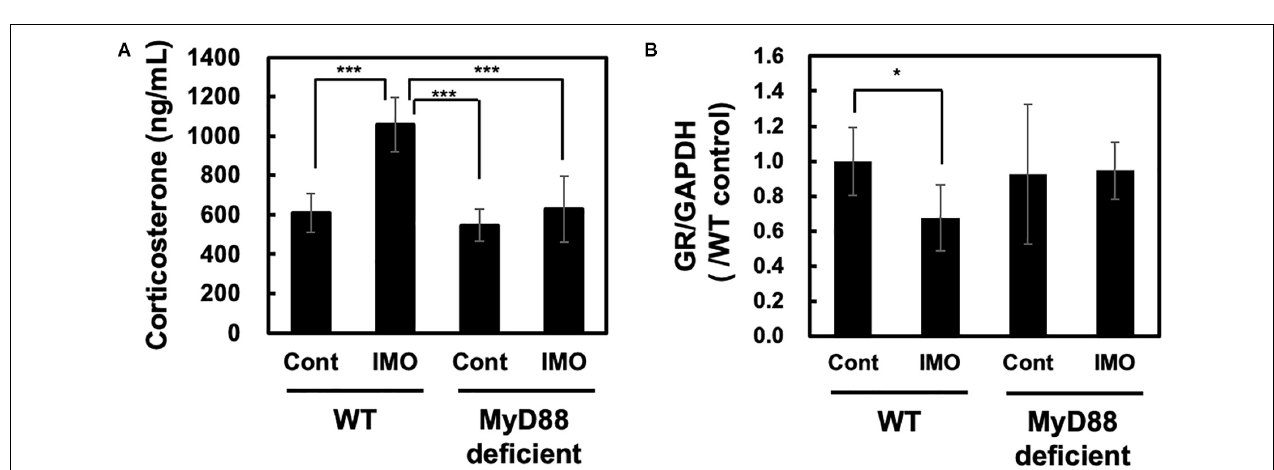
FIGURE 2 | Corticosterone and glucocorticoid receptor levels in MyD88-deficient mice exposed to immobilization stress. (A) Immobilization stress-induced production of corticosterone was impaired in MyD88-deficient mice. Serum corticosterone levels in wild-type (WT) and MyD88-deficient (MyD88 deficient) mice were measured 8 h after the immobilization stress. Values are presented as means ± SD. Two-way ANOVA with Tukey’s honestly significant difference post hoc comparison was performed. The results of two-way ANOVA were as follows: immobilization: F (1) = 37.990 p < 0.0001; genotype: F (1) = 32.550, p < 0.0001; immobilization × genotype interaction: F (1) = 17.839, p = 0.0002. The result of post hoc test were as follows: *** p < 0.001, WT-cont vs. WT-IMO; WT-IMO vs. MyD88 deficient-cont; WT-IMO vs. MyD88 deficient-IMO; (WT-cont: n = 9; WT-IMO: n = 9; MyD88 deficient-cont: n = 8, MyD88 deficient-IMO: n = 9). (B) Expression levels of glucocorticoid receptor (GR) mRNA in MyD88-deficient mice did not change after exposure to immobilization stress. Hippocampus samples were obtained 8 h after exposure to immobilization stress (IMO) and subjected to real-time PCR analysis. Values are presented the ratio to WT control group as means ± SD. Two-way ANOVA with Tukey’s honestly significant difference post hoc comparison was performed. The results of two-way ANOVA were as follows: immobilization: F (1) = 2.801, p = 0.106; genotype: F (1) = 1.154, p = 0.293; immobilization × genotype interaction: F (1) = 3.595, p = 0.069. The result of post hoc test were as follows: * p = 0.023, WT-cont vs. WT-IMO; (WT-cont: n = 10; WT-IMO: n = 10; MyD88 deficient-cont: n = 5, MyD88 deficient-IMO: n = 5).